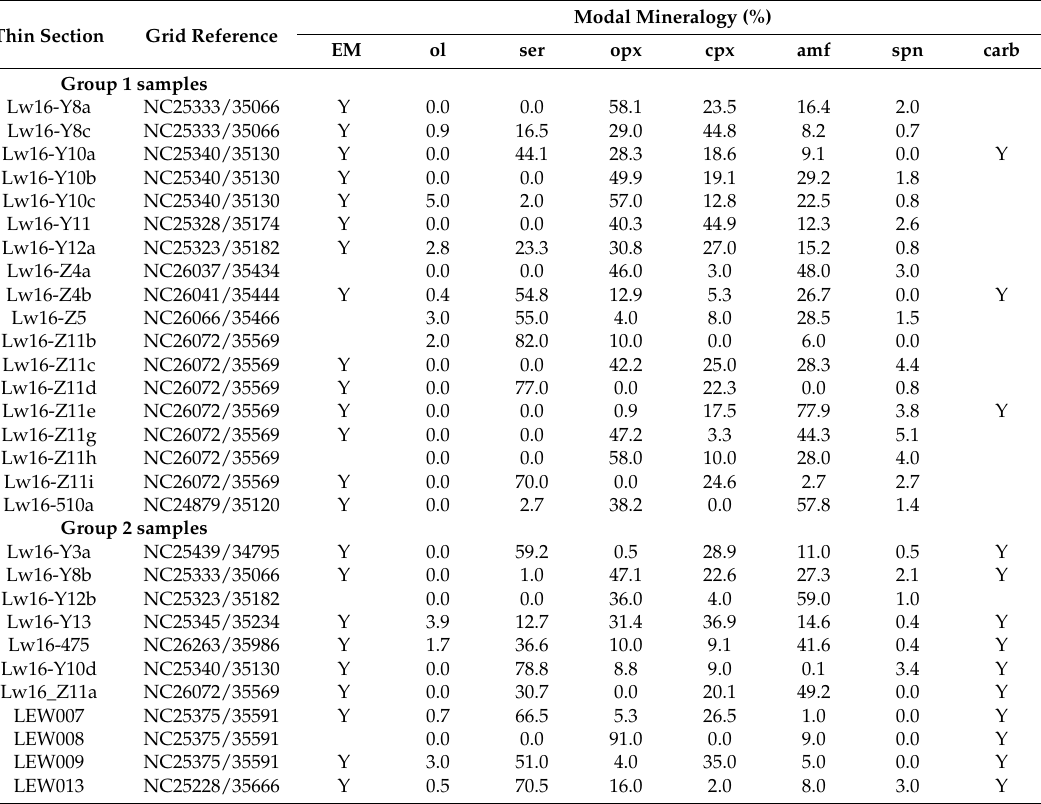
Table 1. Location and modal mineralogy for each